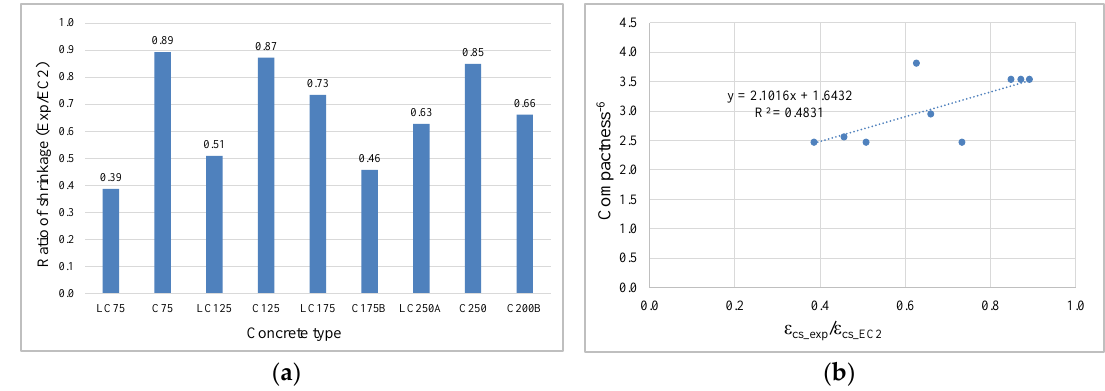
Figure 5. Influence of compactness on ratio of shrinkage Exp/EC2: ( a ) ratio for each concrete; ( b ) correlation between the ratio and compactness −6 .